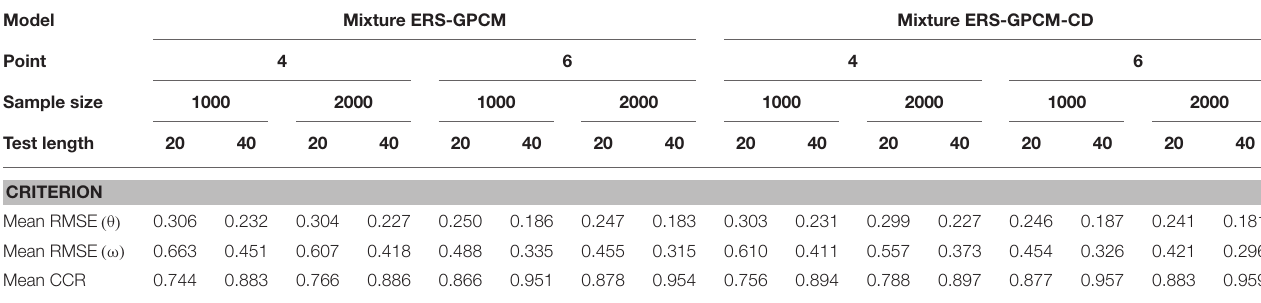
TABLE 5 | Statistical summary of the person parameter recovery in the mixture ERS-IRT models.